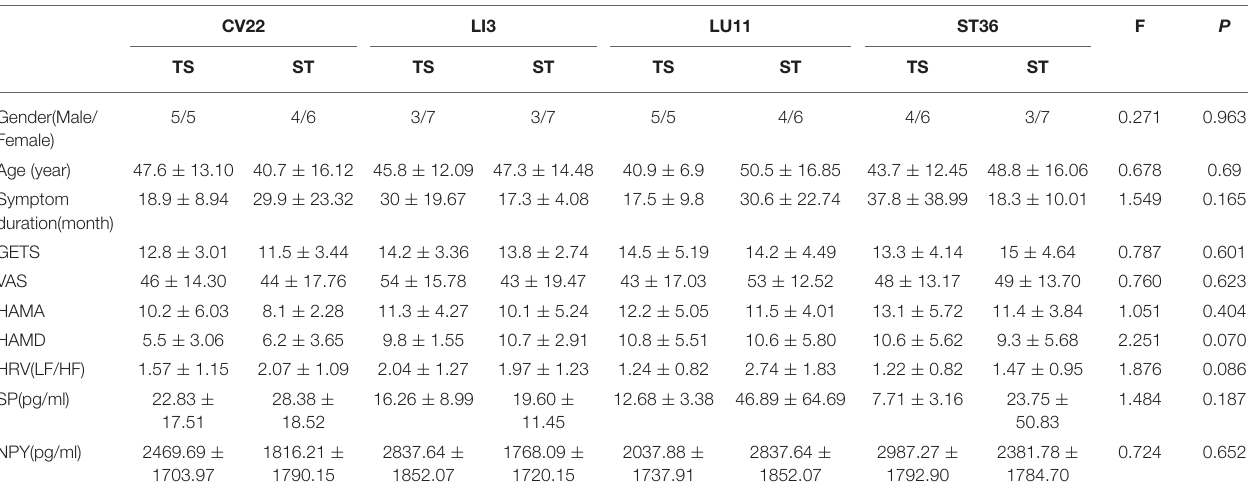
TABLE 1 | Demographic and baseline characteristics of study patients.